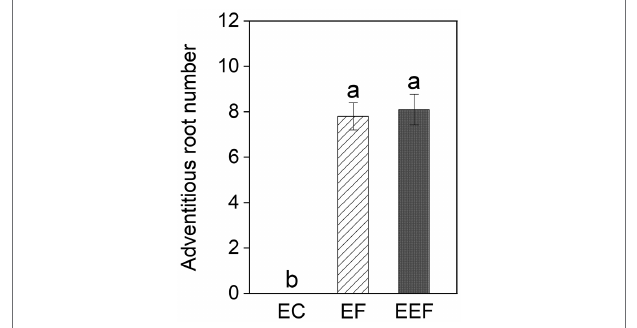
A p-value smaller than 0.05 is formatted in bold.